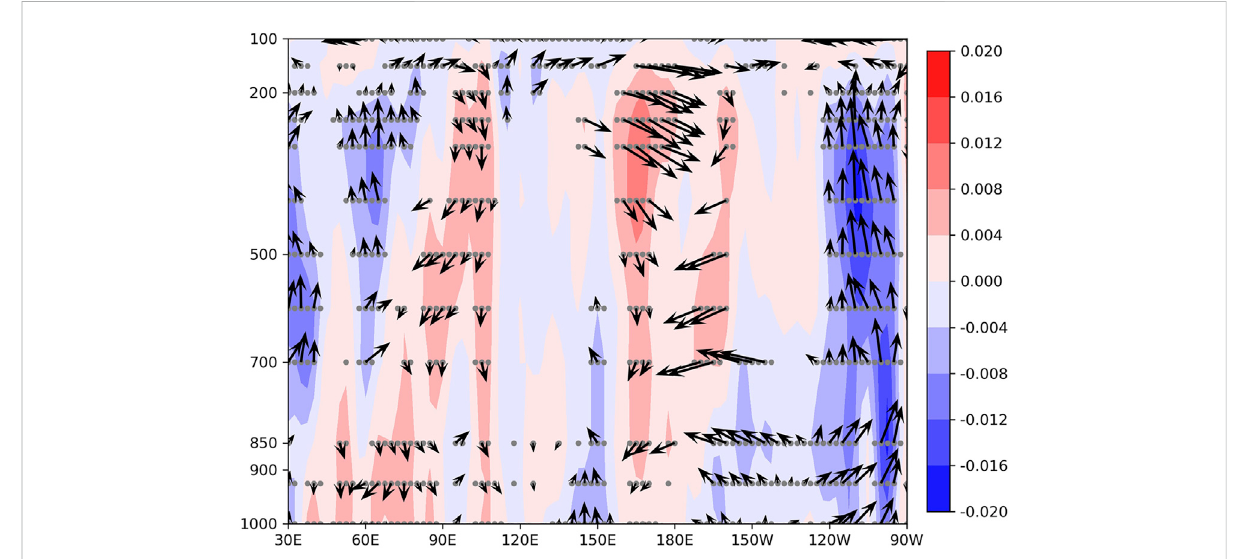
Composite anomalies of mean vertical velocities (shading, units: Pascal s − 1 ) pro fi le between 10 ° N and 25 ° N for the June – November over the Indo-Paci fi c Ocean. Arrows indicate zonal velocities (units: m s − 1 ) and vertical velocities (units: 100 Pascal s − 1 ). Indian Ocean region [60 ° E-100 ° E],